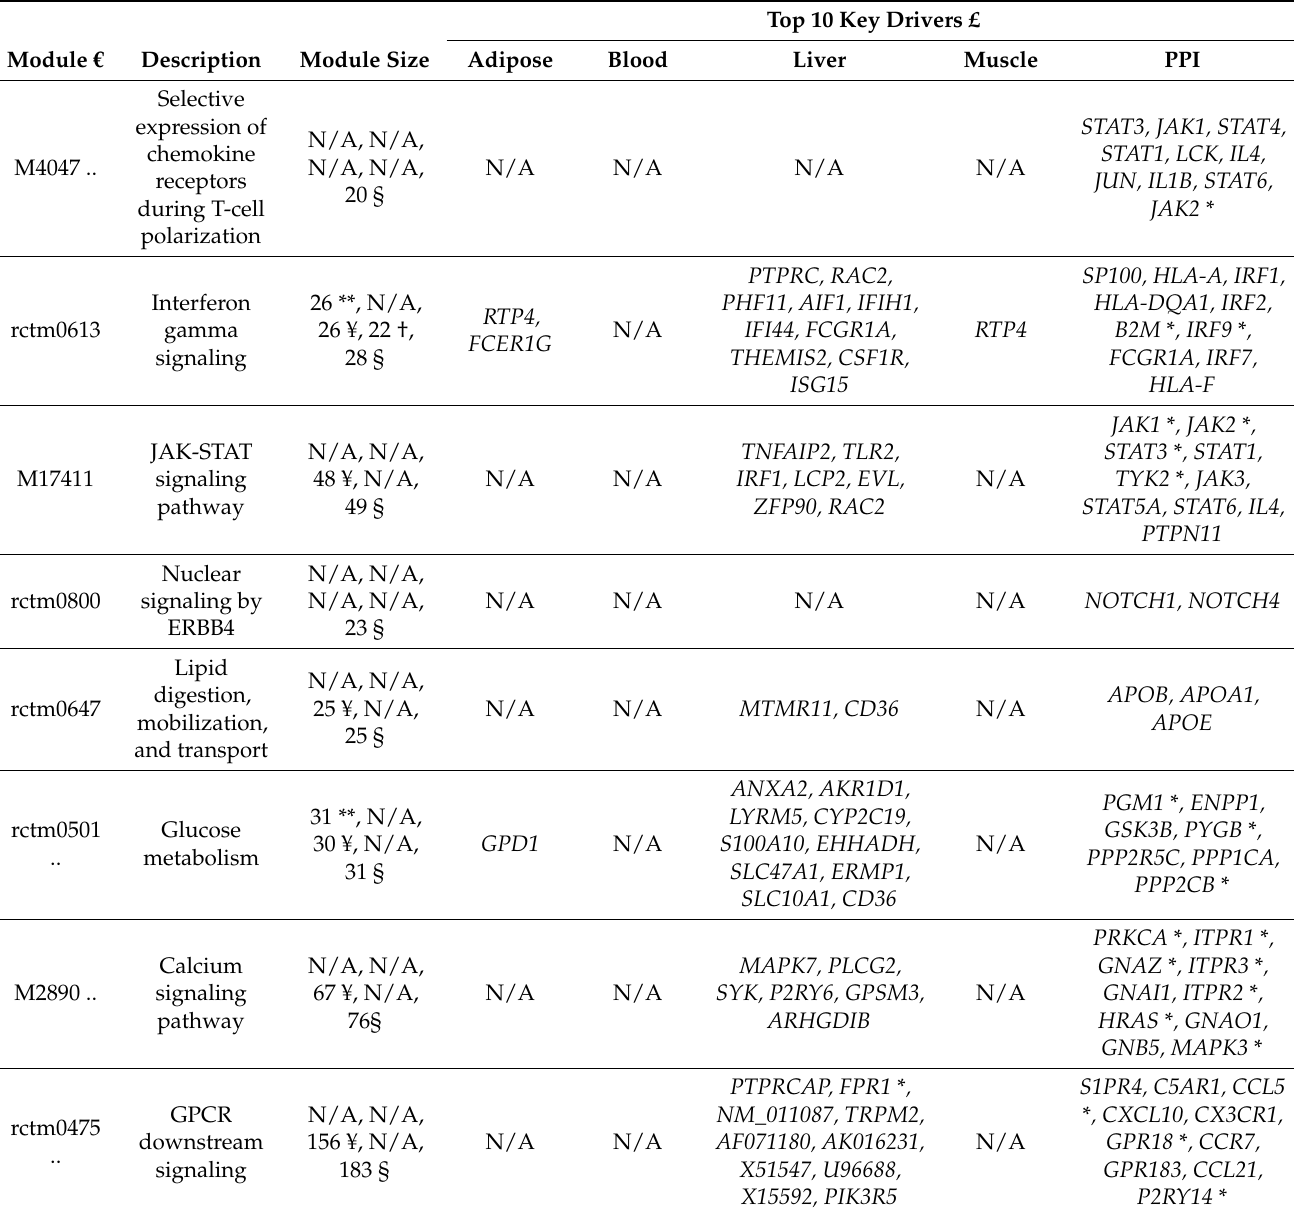
Table 2. MSEA Meta-analysis of CRP and IL6 pathways (whole blood eQTL mapping) and corresponding tissue specific– network key